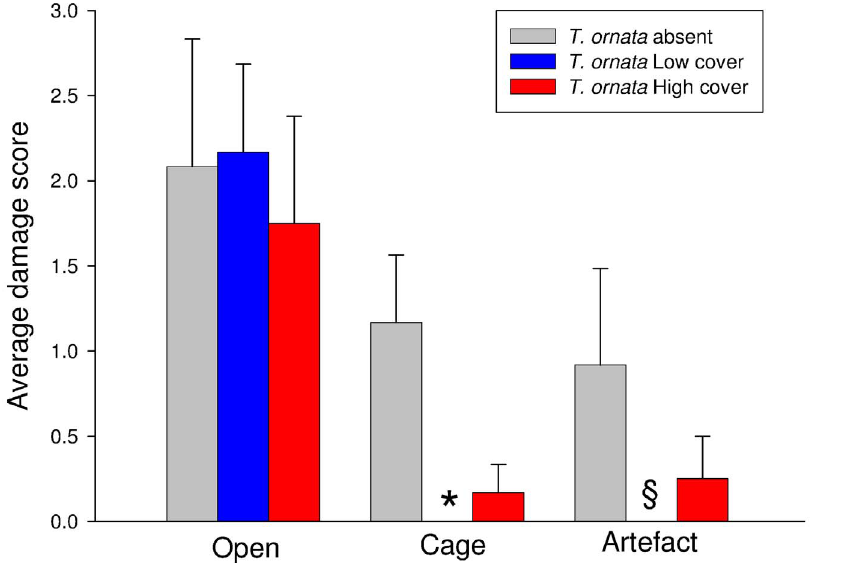
Figure 4. Damage score (mean + 1SE) experienced by Acroporapulchra individuals when exposed to different combinations of consumers (open versus cage versus half-cage) and Turbinariaornata cover (absent versus medium versus high). Data are pooled across slabs; n =12. * = 0; 1 = no data (the combination T. ornata medium cover and half-cage was not included in the experiment design).